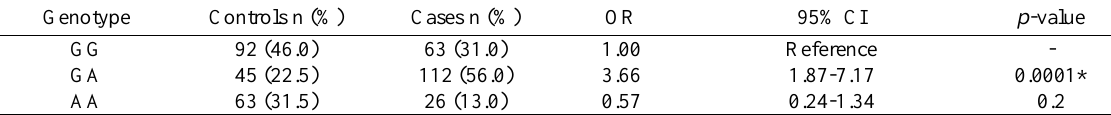
Table 3 . Association of rs1800460 polymorphism of the TPMT gene with ALL risk Genotype Controls n